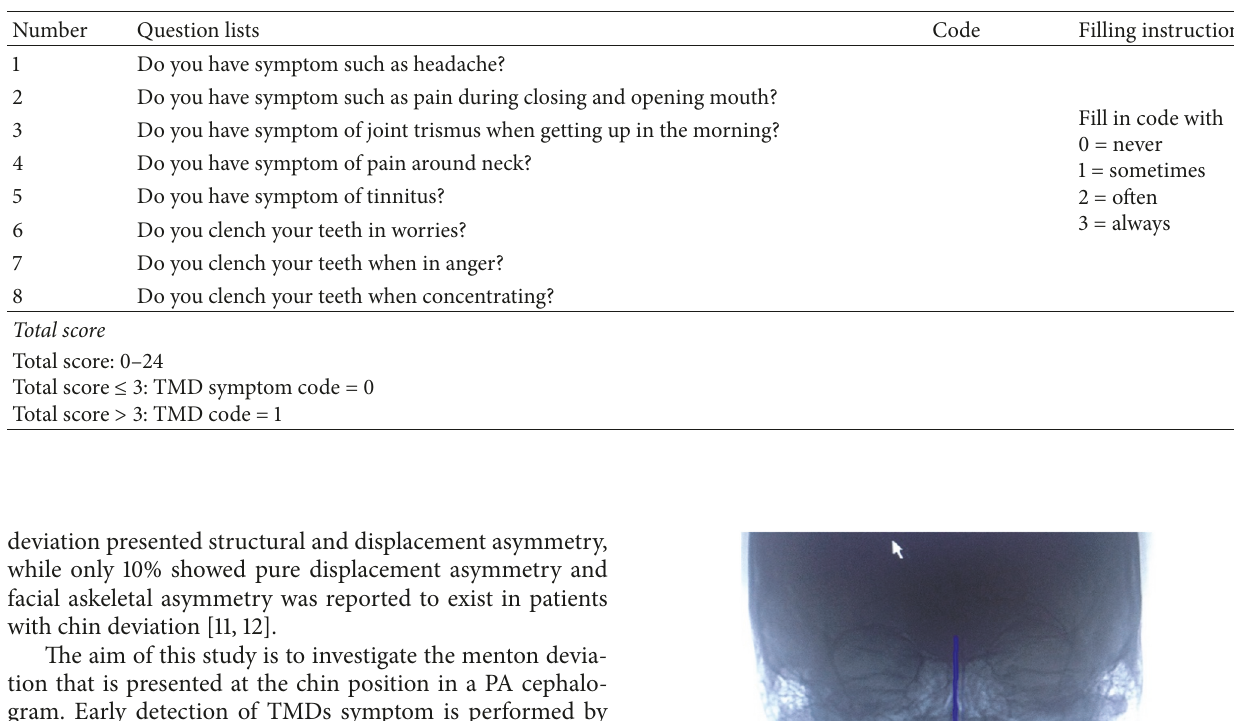
Table 1: Temporomandibular disorder diagnostic index (TMD-DI).